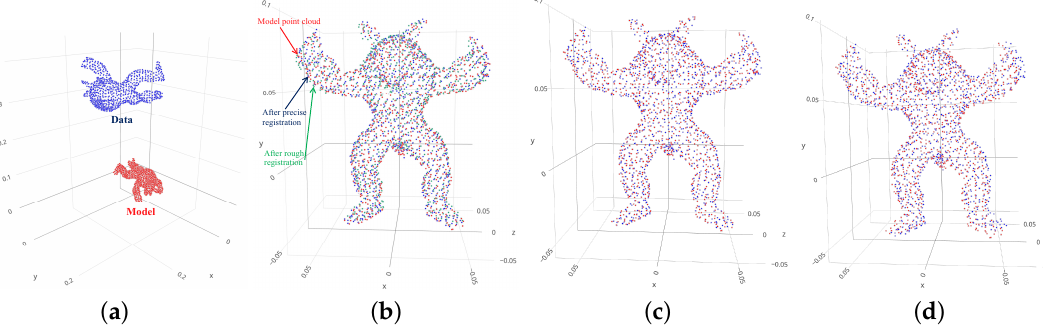
Figure 16. The registration results of Armadillo data for test sample 5: ( a ) The initial state; ( b ) 3-D CNNs then 2-D CNNs, ( c ) RANSAC then ICP, ( d ) Fast Global